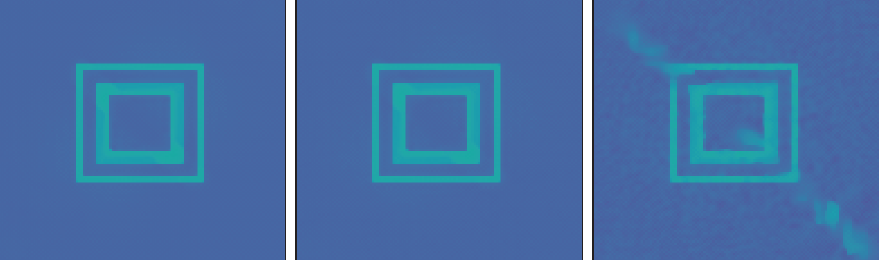
Figure 2. Top row: reconstructions using post-processing network Φ ( 1 ) . Middle row: NETT re- ( 1 ) . Bottom row: NETT reconstructions using constructions using R Reconstructions from data without noise, low noise ( σ = 0.01) and high noise ( σ = 0.1 ) .